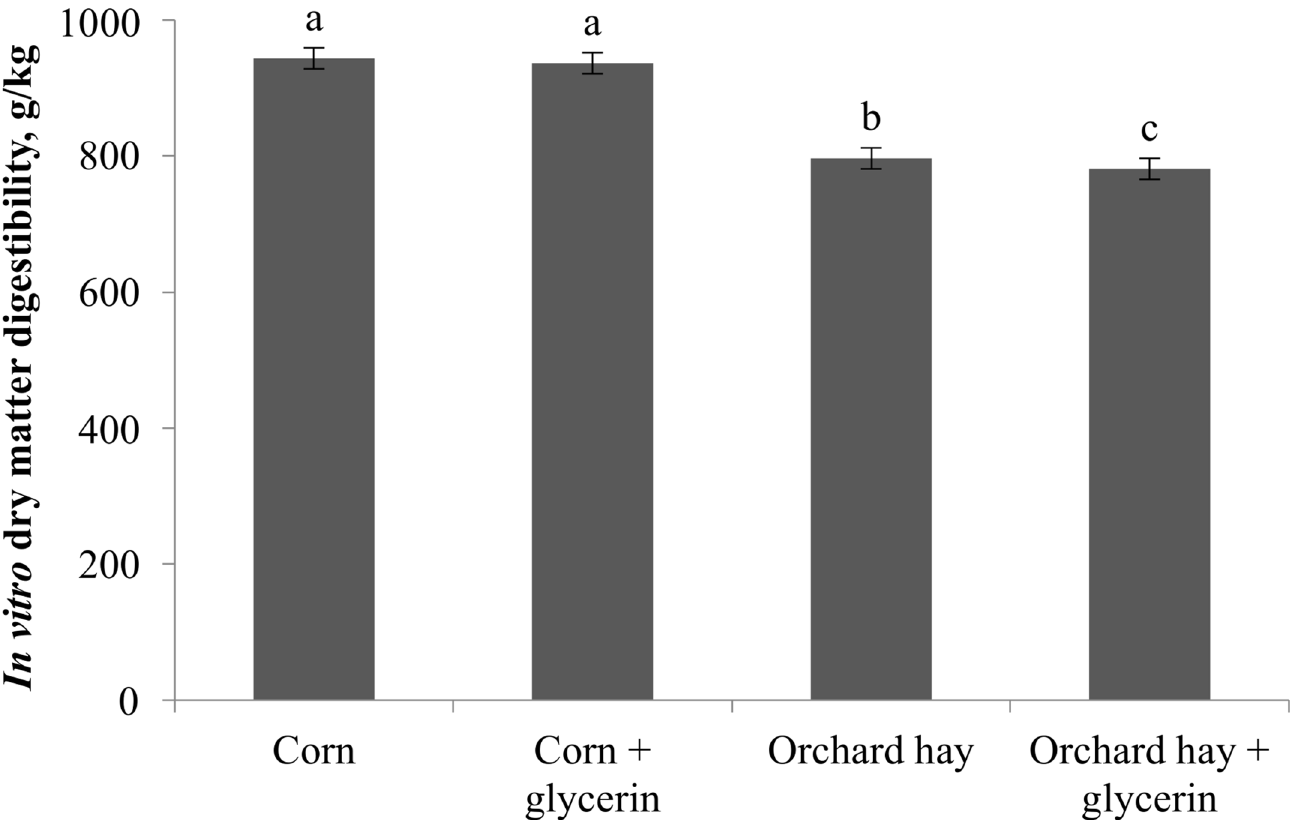
Fig 3. The IVDMD of individual ingredients (corn and orchard hay) and co-incubation with glycerin in Exp. 5, using two systems of four 4-L digestion vessels (Daisy II system, Ankom technology, NY, USA) in four consecutive 48-h fermentation batches. a,b,c Means with different superscripts are different (P <